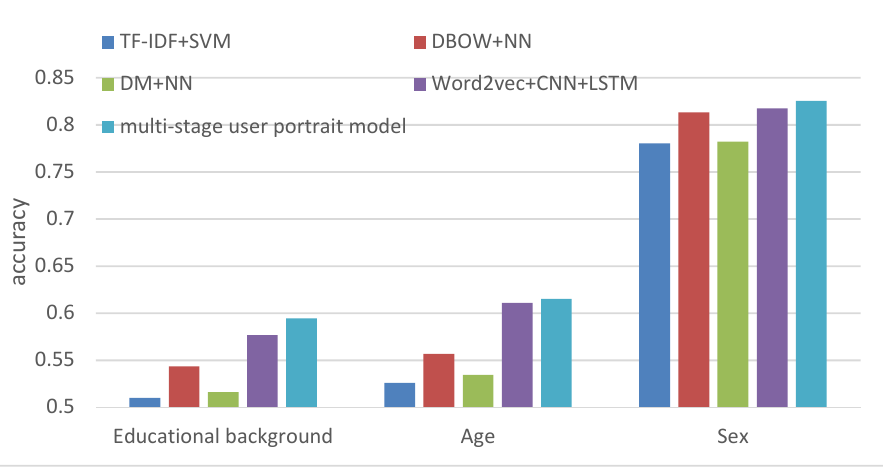
Figure 9. Comparison of prediction accuracy of the models.